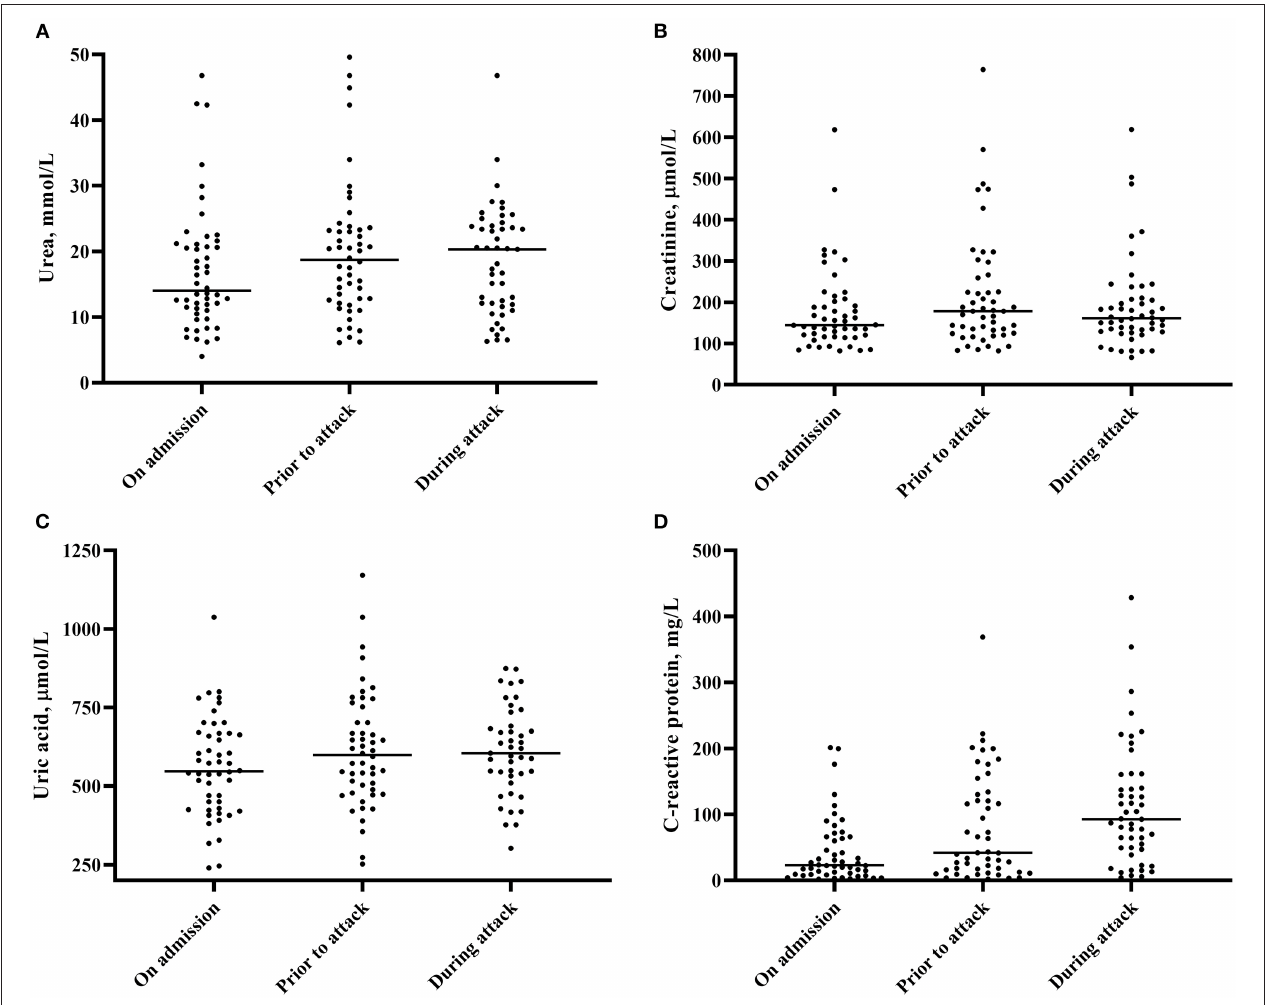
FIGURE 2 | Changes in serum urea (A) , serum creatinine (B) , serum uric acid (C) and serum C-reactive protein concentration (D) . Medians are